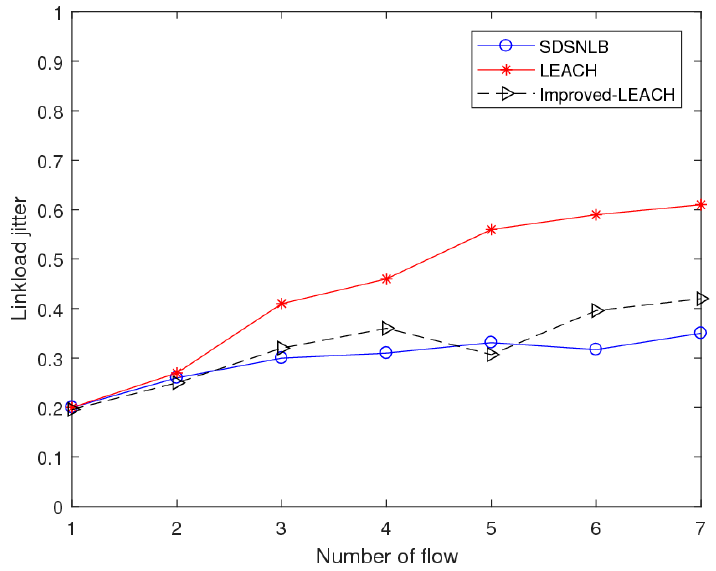
Figure 6. Link load jitter varies with the number of data streams.